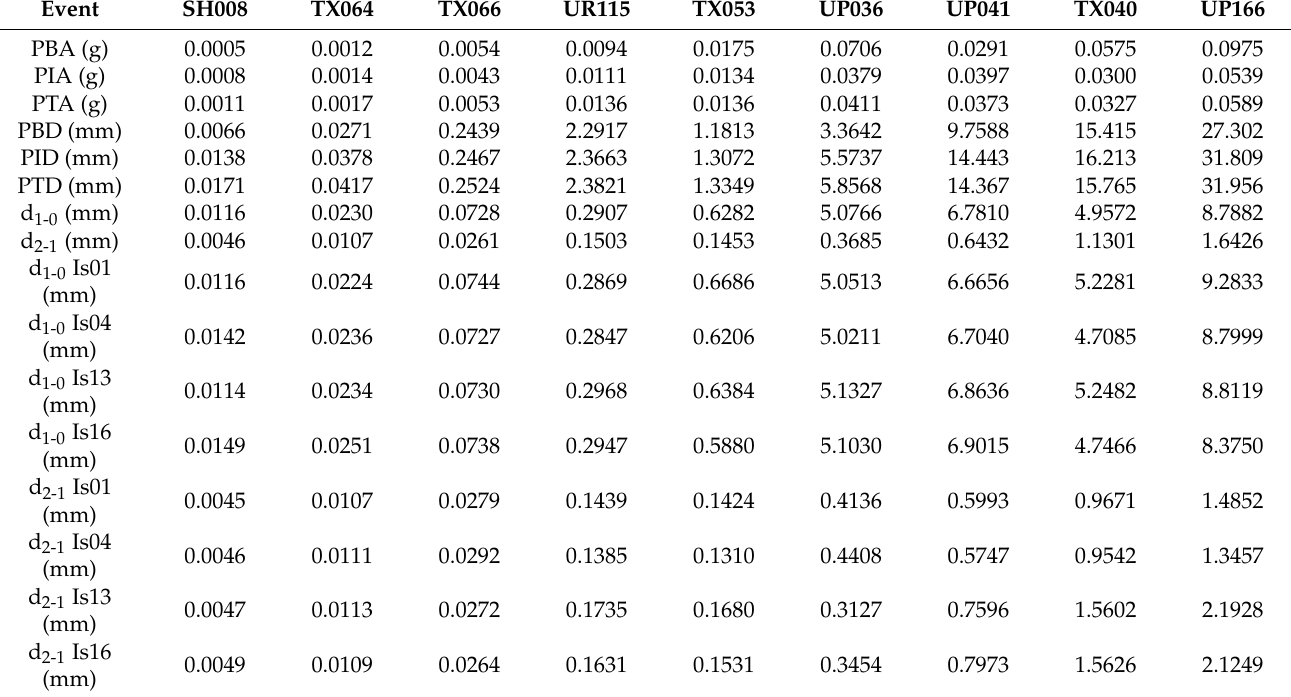
Figure 17. Maximum relative displacement between the gravity centers at L1 and L0, and at L2 and L1, for the considered seismic events. Table 4. Maximum accelerations, displacements, relative displacements of the gravity centers and maximum relative displacements at the corner isolators for the selected seismic